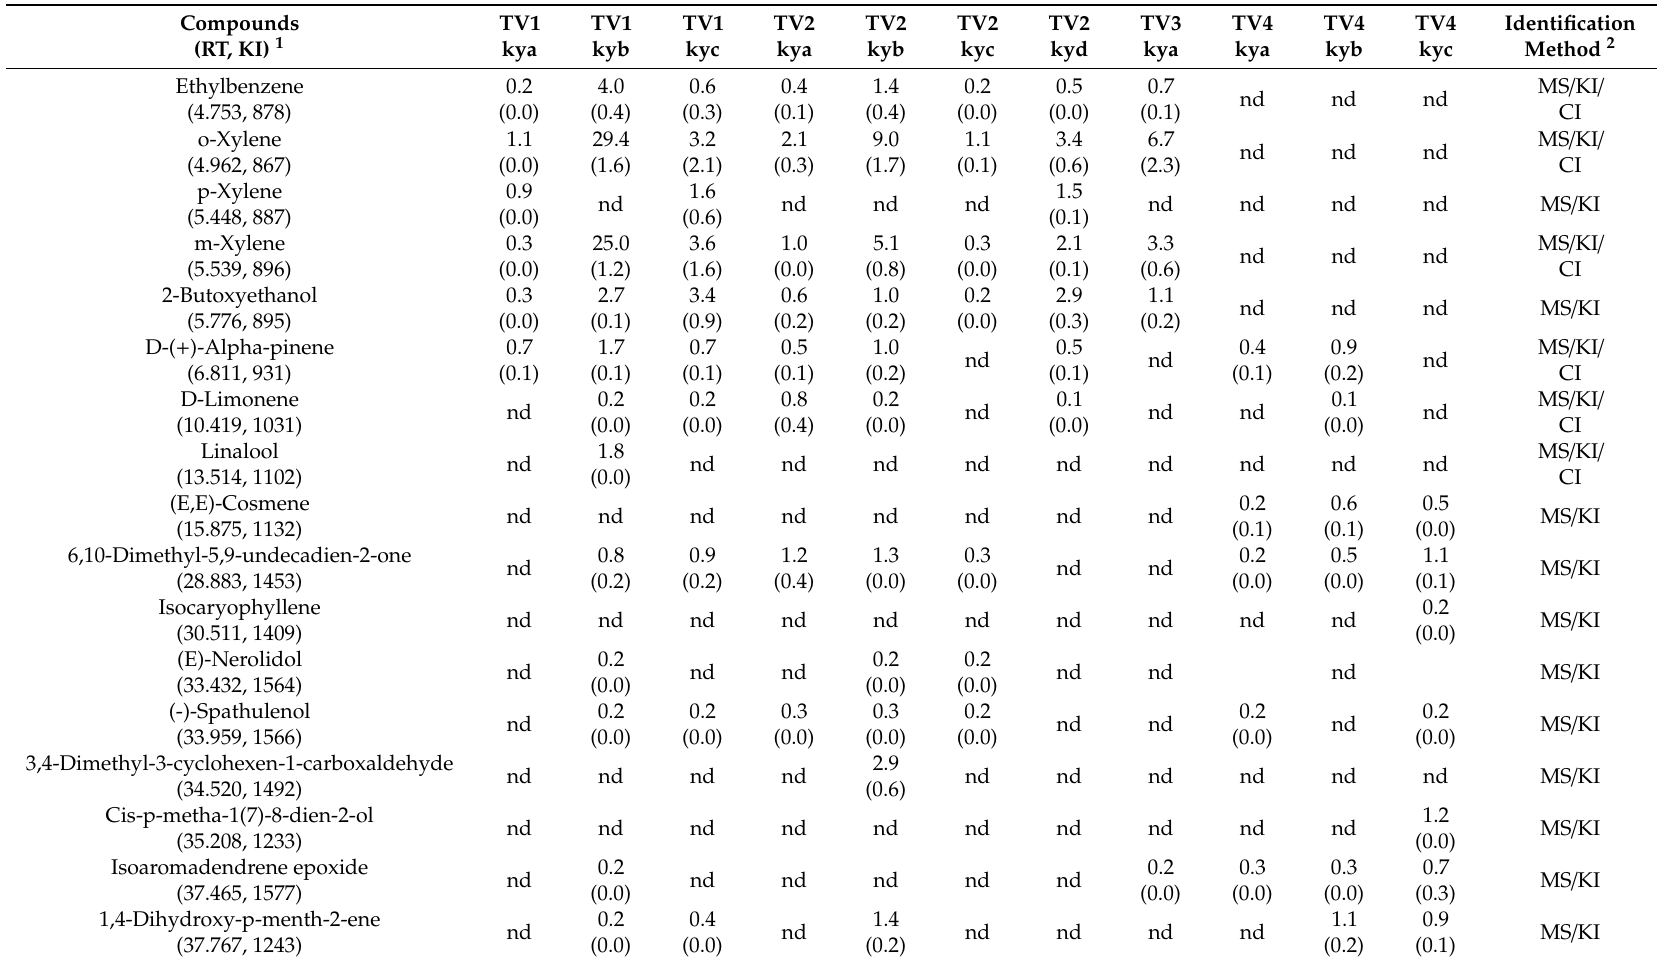
Table 2. Mean peak area (% ± standard error of the mean (SEM)) composition of major chemical constituents identified in the essential oils of T. vogelii samples from Kyadogho